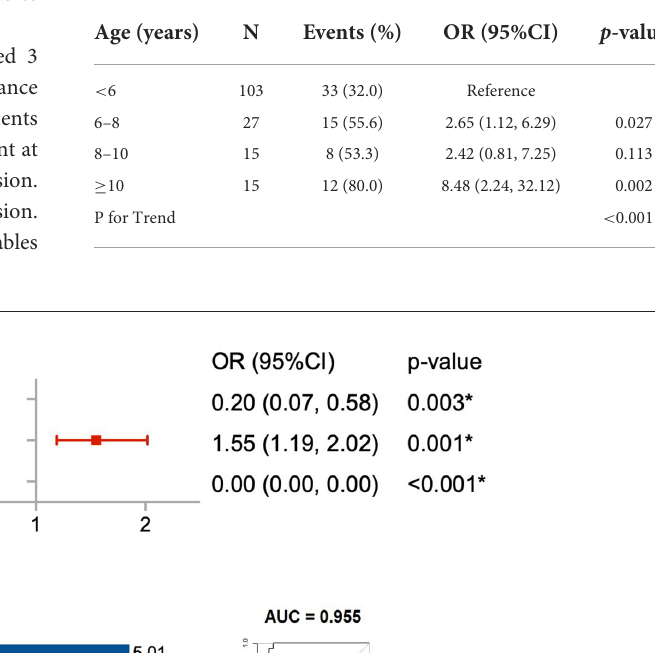
TABLE 3 Association between age and the risk of regression.